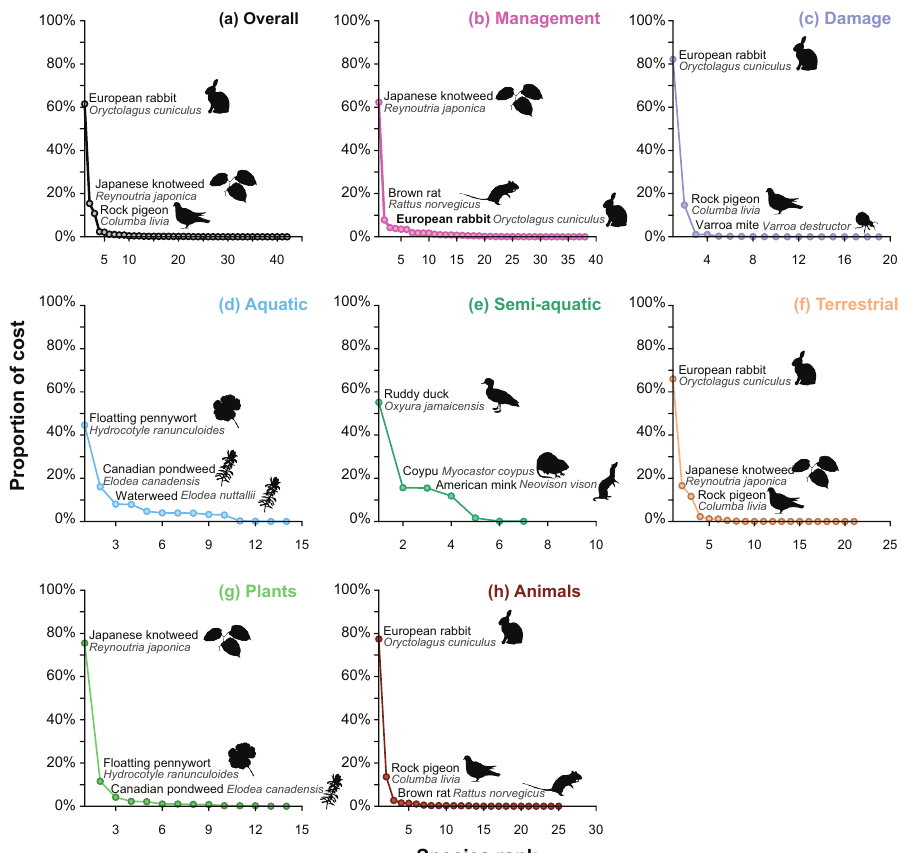
Figure 3. Whittaker plots illustrating ranked proportional cost contributions across species for a overall b management c damage d aquatic e semi-aquatic f terrestrial g plant and h animal cost categories. The top three highest-contributing species are labelled on each subplot, for example, the European rabbit ranks as the costliest species a overall, for c damage costs and amongst the terrestrial organisms ( f ) and animal kingdom ( h ), representing 62%, 82%, 66% and 77% of costs in the respective categories. Note the differences in x -axes